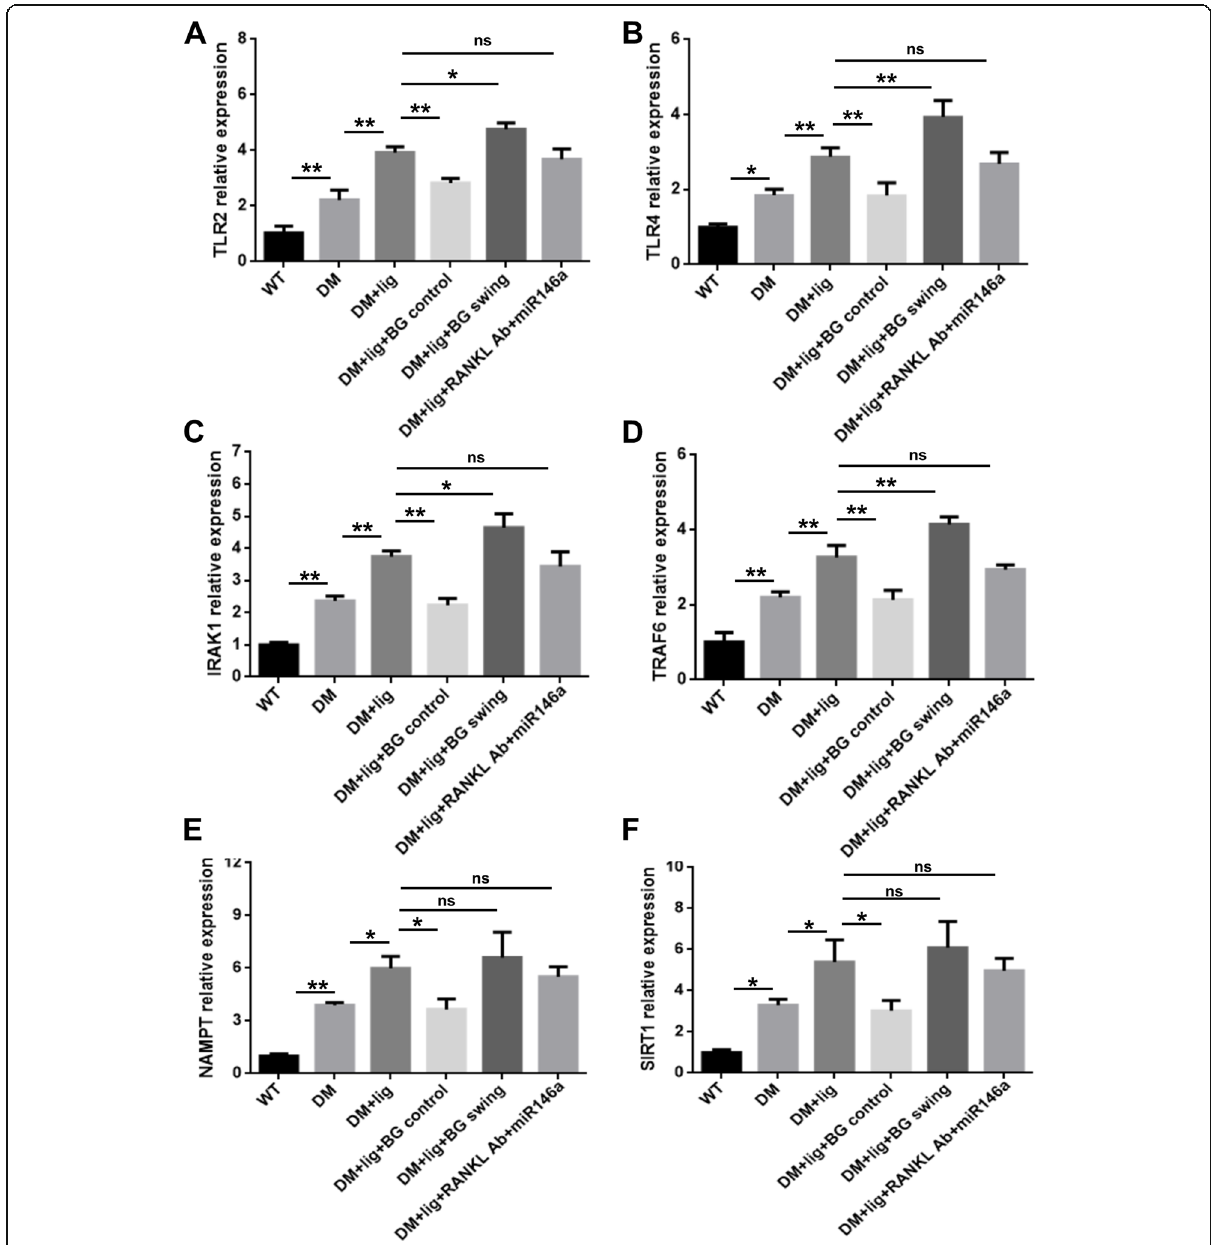
Fig. 5 The mRNA expression of TLR and NAMPT signaling members in peri-implant gingival tissues. Gingival tissues around ligatured site were excised and processed for RT-qPCR analyses to determine mRNA level of a TLR2, b TLR4, c IRAK1, d TRAF6, e NAMPT, and f SIRT1 (mean ± SD, n = 3, * p < 0.05, ** p < 0.01, ns, no